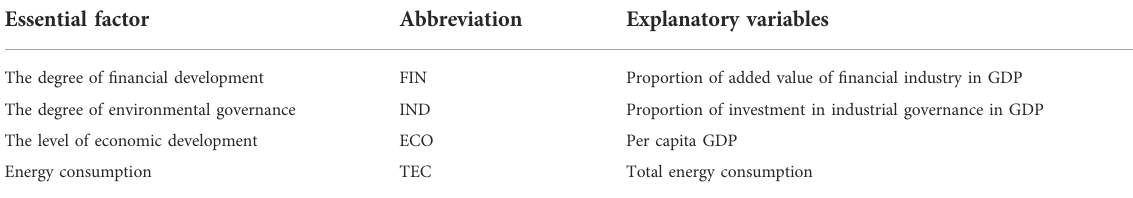
TABLE 4 Indicators of in fl uential factors.